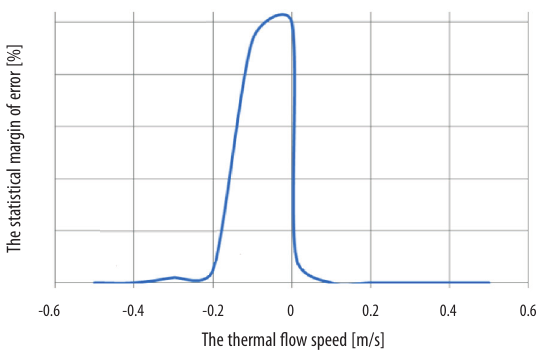
Fig. 8. Statistical margin of error detection of thermal flow when angle of attack is 0.0 degrees